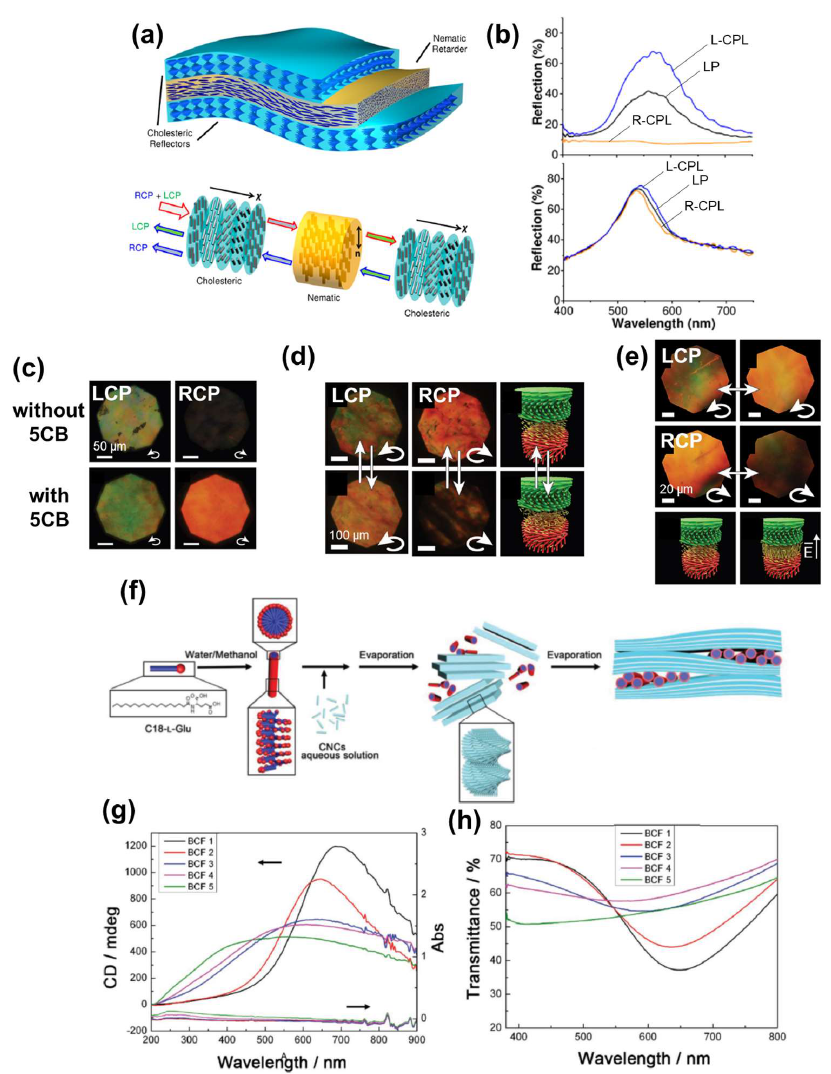
Figure 4. ( a ) Schematic describing the sandwich film composed of cellulose nanocrystal (CNC)-based cholesteric liquid crystal (ChLC) outer layers and a nematic inner layer, and the mechanism of the handedness-independent circularly polarized light (CPL) reflection. LCP, left-handed circular polarizer; RCP, right-handed circular polarizer. ( b ) Reflection spectra of a single CNC ChLC film (top) and a sandwich film (bottom) with linearly polarized (LP) light, right-handed CPL (R-CPL), and left-handed CPL (L-CPL) incident light (( a , b ) were reprinted with permission from [66], copyright (2021) American Chemical Society). ( c ) Reflection images of a simple CNC ChLC film and a CNC–4- pentyl-4 (cid:48) -cyanobiphenyl (5CB) composite through LCP and RCP. ( d ) Reflection image of a CNC–5CB composite through LCP and RCP at 30 ◦ C (top) and 34.5 ◦ C (bottom). ( e ) Reflection image of a CNC–5CB composite through LCP and RCP; before (left) and after (right) applying an electric field parallel to the cholesteric helical axis (( c – e ) were reproduced from [67] by permission of Wiley). ( f ) Schematic presenting formation of the ChLC structure with a distributed helical pitch in the presence of N -stearoyl-L-glutamic acid (C18–L-Glu micelles). ( g ) Circular dichroism spectra and ( h ) transmission spectra of broadband cellulose films (BCFs) with various portions of C18–L-Glu (( f , g ) were reproduced from [68] by permission of